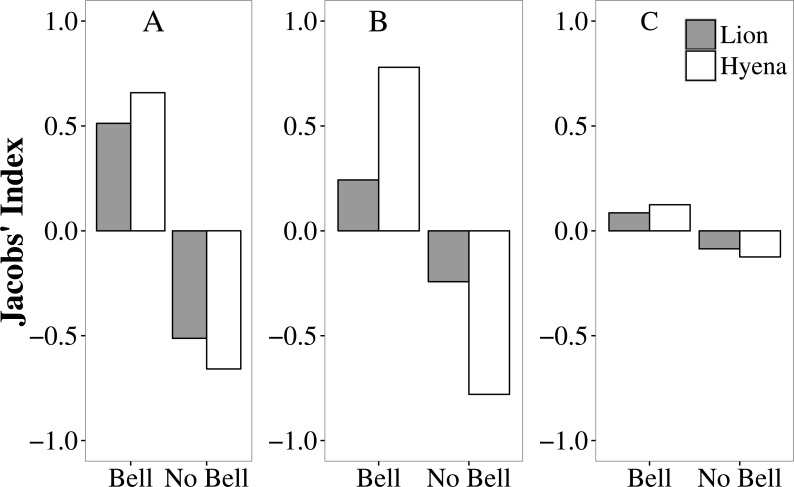
Selection (Jacobs’ Index) by lions (grey bars) and hyaenas (white bars) for livestock with and without bells in the Tsholotsho, Mabale and Mvuthu-Shana study sites (2009–2013).More positive values indicate preference while more negative values indicate avoidance.